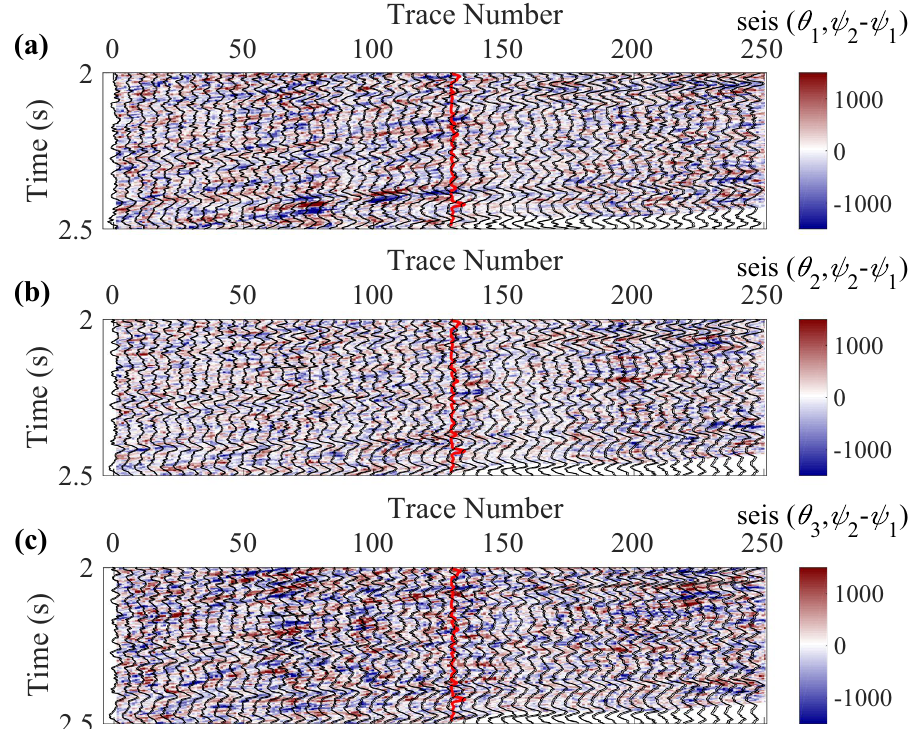
Figure 6. Seismic amplitude difference data between azimuth ϕ 1 = 40 ◦ and azimuth ϕ 2 = 130 ◦ , where (a) is the near angle of incidence, (b) is the middle angle of incidence, and (c) is the far angle of incidence, respectively.